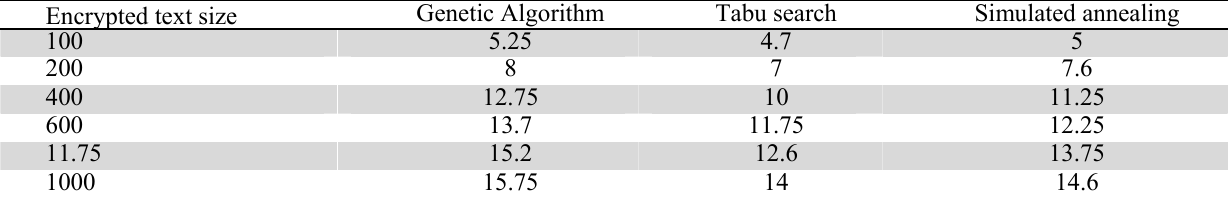
Number of keys obtained against different password text size Encrypted text